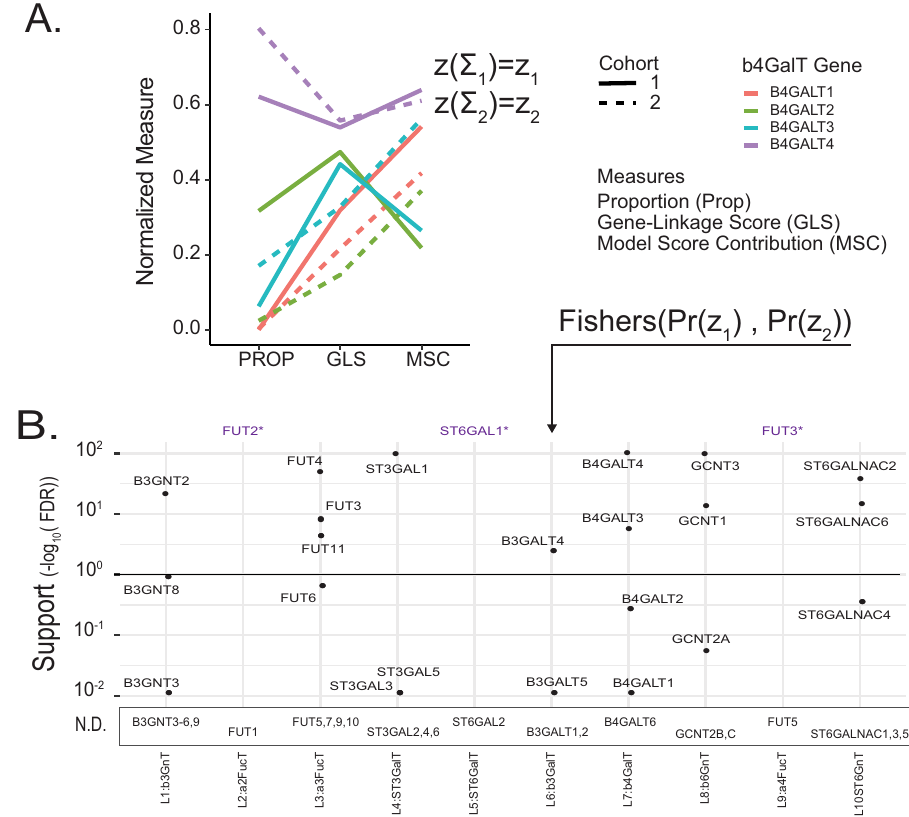
Fig. 5 Gene expression correlation with model fl ux predicts enzymes involved in HMO biosynthesis. A To determine the gene expression that best explains fl ux through each reaction in each glycomics-transcriptomics matched sample, we examined the proportion of high-performing models were each gene was most fl ux-correlated (PROP, Supplementary Fig. 11), we also examined the gene-linkage score (GLS) and Model Score Contribution (MSC). Brie fl y, the GLS measures the correlation between expression of different glycosyltransferase isozymes and normalized fl ux, whereas the MSC was an enrichment metric assessing the impact of glycosyltransferase isozyme expression on model scores (Supplementary Methods 4.4, 4.5.2, and 5.3). For this visual, each measure was max-min normalized between 0 and 1. Genes were selected based on high performance on all three measures across cohorts (line type). B We summarize the three performance scores from panel A across cohorts into a single support score (see Methods section). Brie fl y, “ Support ” is derived from the p-value for the sum of PROP, GLS, and MSC z -scores (relative to a permuted background), Fisher-pooled across cohorts then False Discovery Rate (FDR) corrected across genes (see Methods section). Unmeasured genes appear below the plot in the Not Determined (N.D.) box. Genes selected by default (purple, “ * ” ) as the only measured gene candidate (Table